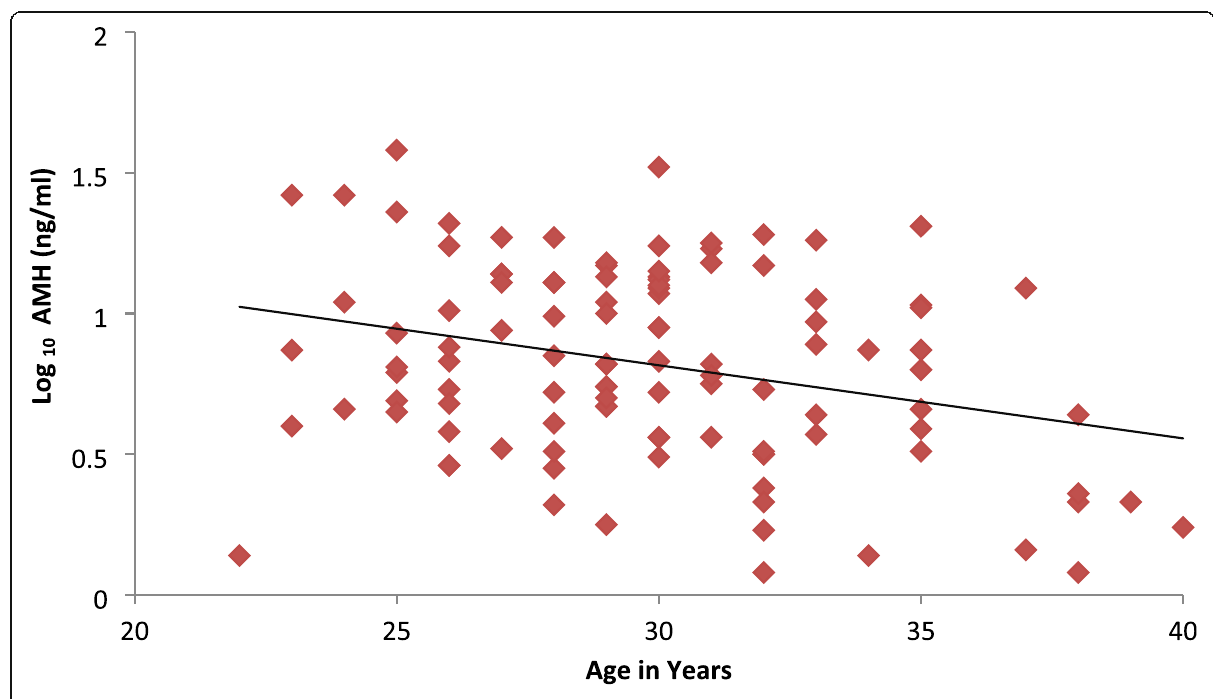
Fig. 2 Scatterplot of Log 10 AMH (ng/mL) by Age in Years in Fertile women